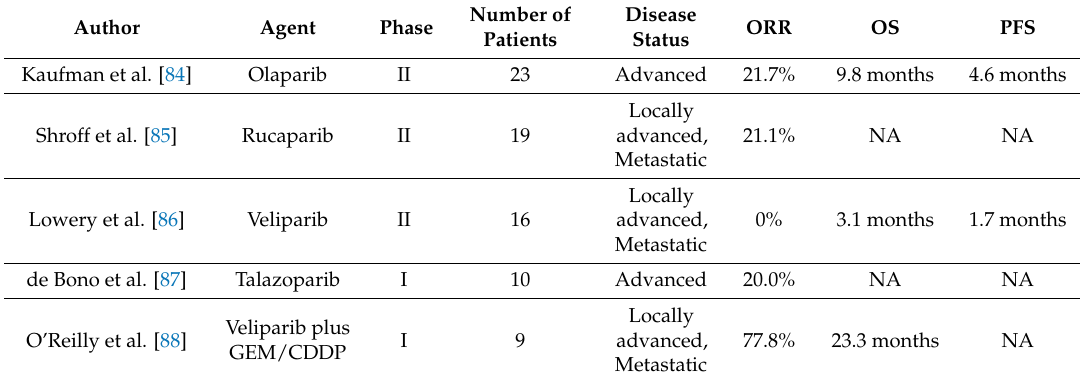
Table 3. Clinical trials of PARP inhibitor for PC patients harboring BRCA1 / BRCA2